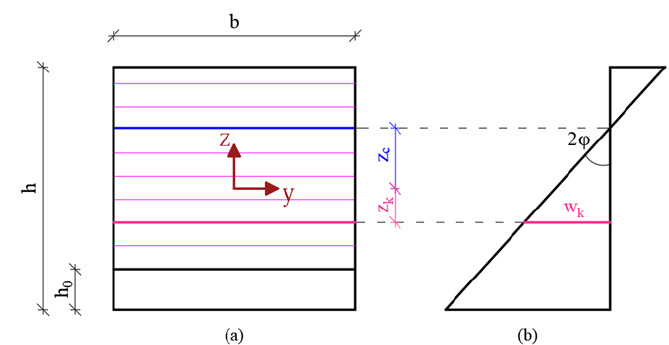
Figure 2. Kinematics of the cracked-hinge model: adapted from [43].